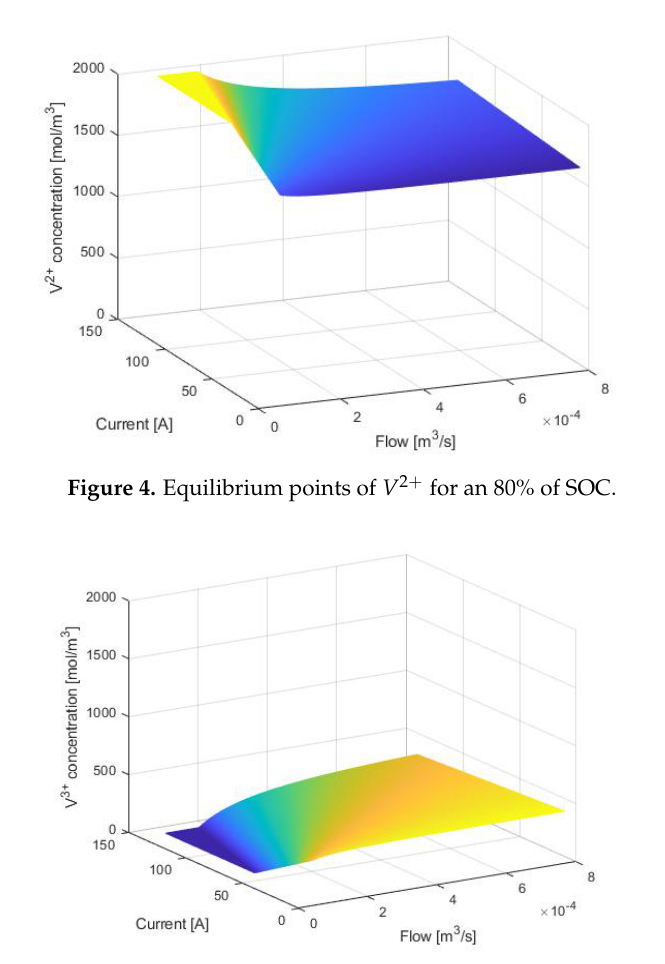
Figure 5. Equilibrium points of V 3 + for an 80% of